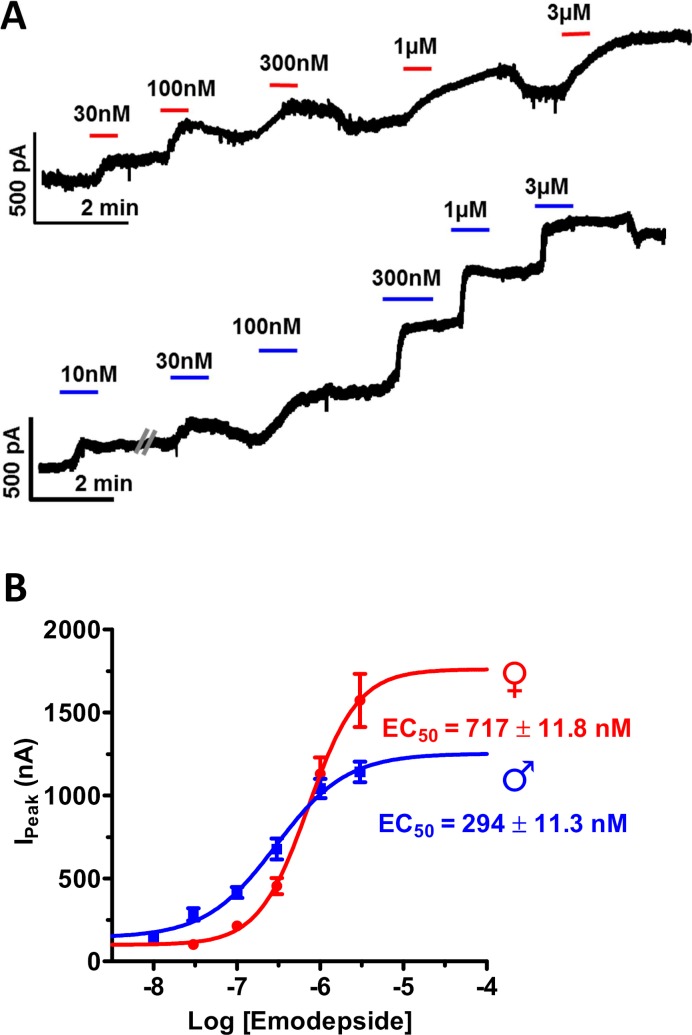
Emodepside produces concentration-dependent outward currents in female and male B. malayi muscle cells.A: Representative current traces of the concentration-dependent emodepside activated standing outward currents from muscle cells of female B. malayi. Cells were whole-cell patch-clamped at -40mV and each concentration of drug was applied consecutively in increasing concentrations (30nM to 3μM) and were allowed to plateau before washing and the next application. B: Emodepside activated outward currents from muscle cells of male B. malayi. C: Concentration-dependent mean current curves for emodepside activated outward currents. Red female symbol: EC50 (Female) = 720 ± 12nM (n = 5), blue male symbol: EC50 (Male) = 294 ± 11nM (n = 5). The male is more sensitive to emodepside than the female.